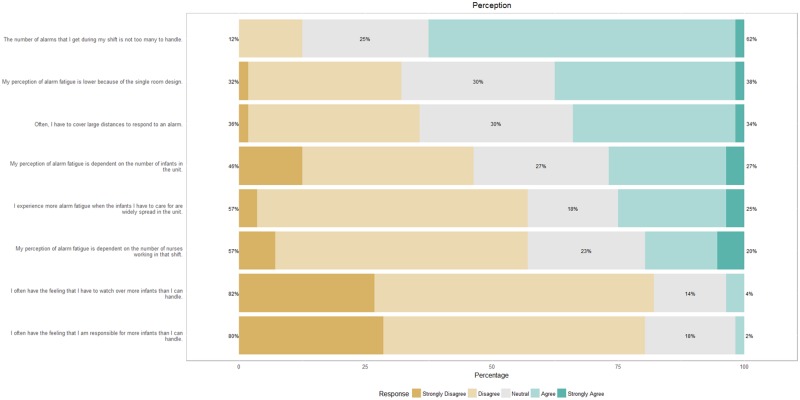
Nursing perceptions on alarms.